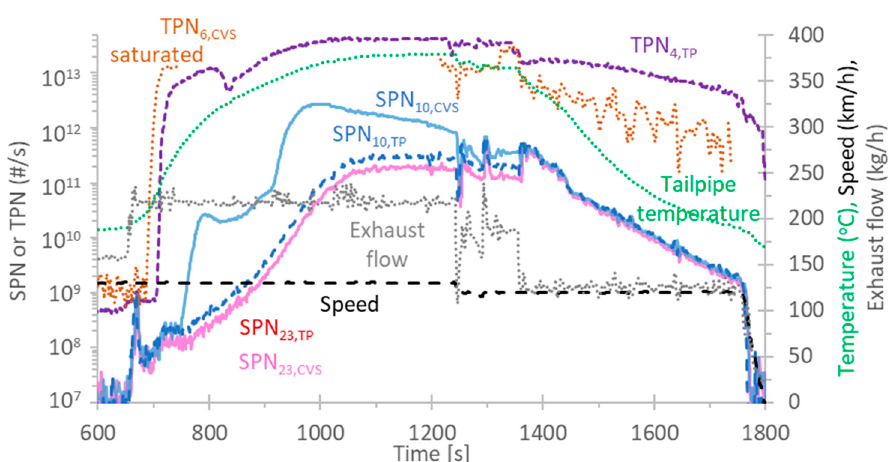
Figure 5. Emissions during the first regeneration event of vehicle #1 (Euro 6d-Temp) at 130 and 120 km/h.